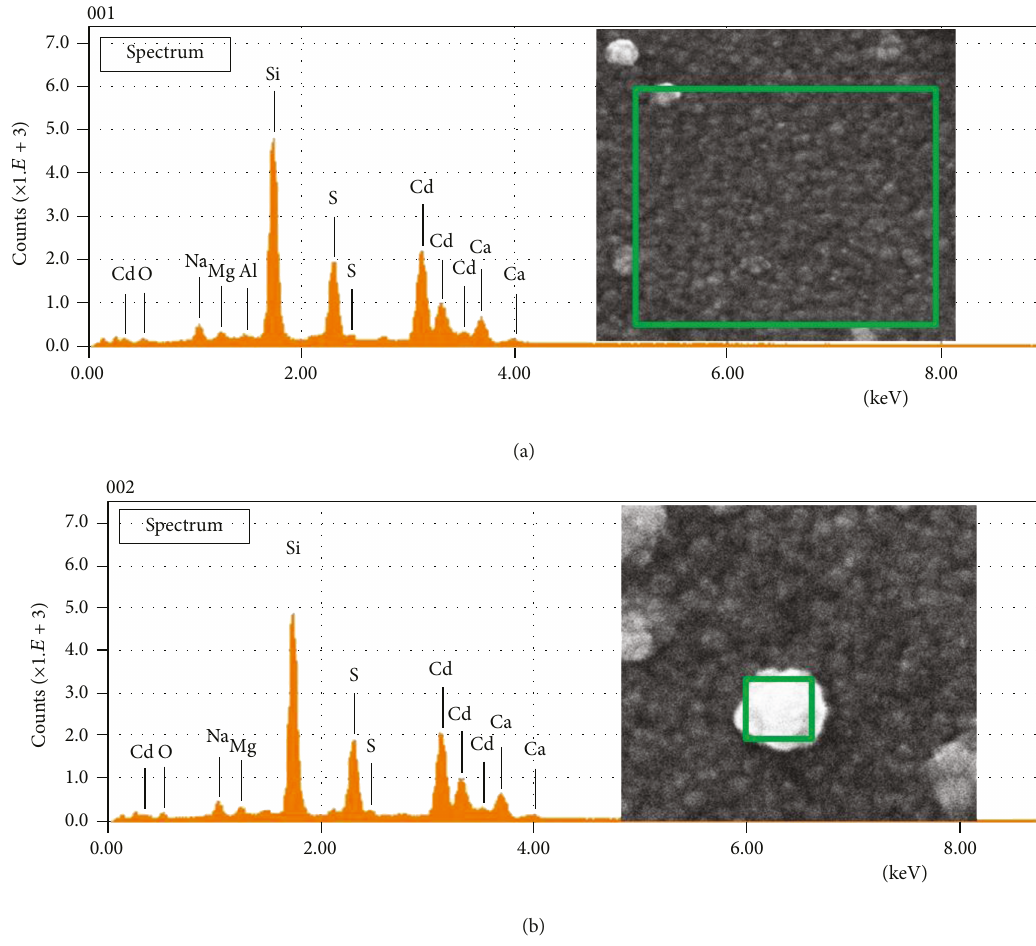
Figure 7: EDS analysis performed on the CdS structure (spectrum “ a ” ) and agglomerated particle (spectrum b).